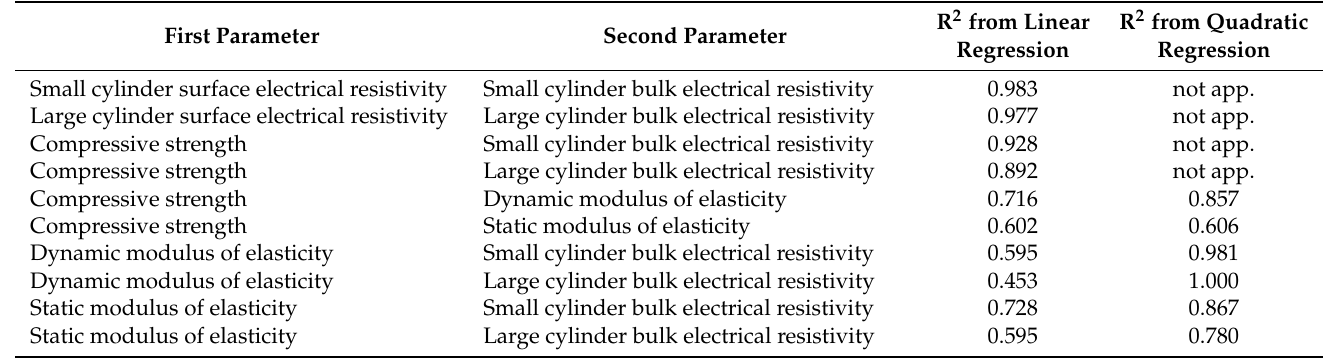
Table 2. The value of the regression analysis results (not app. means that quadratic regression was not